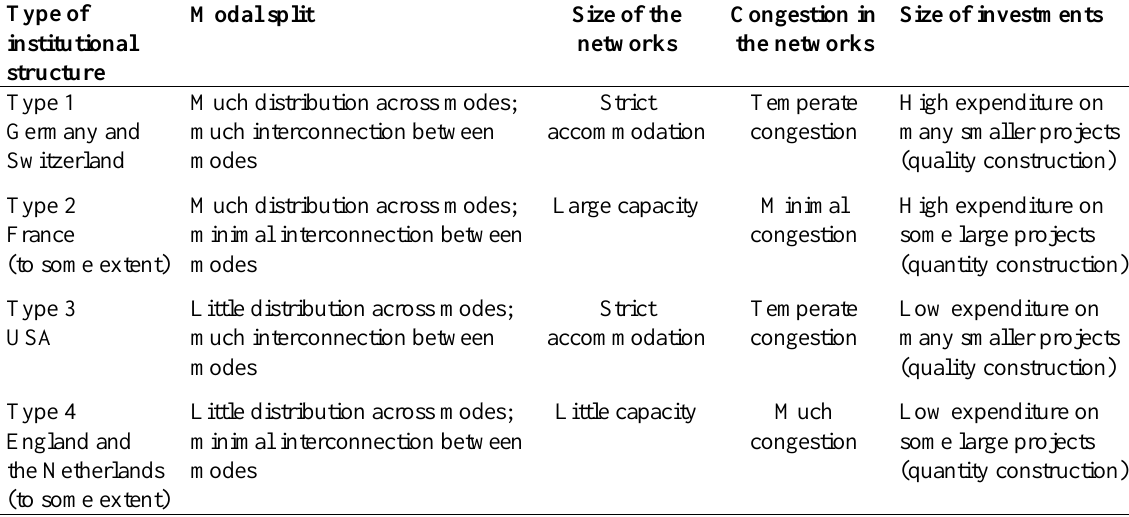
Table 3b. Types of institutional structures and product